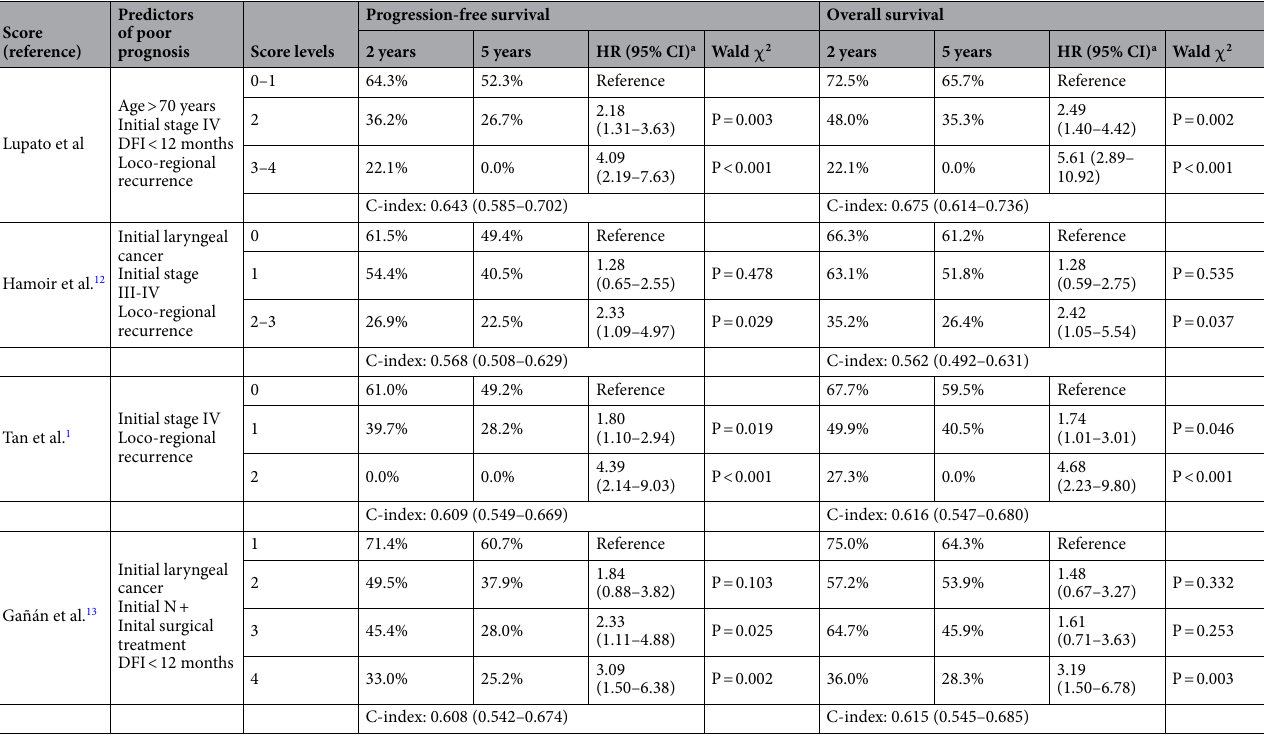
Table 4. Comparison of progression-free survival and overall survival according to predictive scores. DFI disease-free interval. a Estimated through Cox proportional hazard